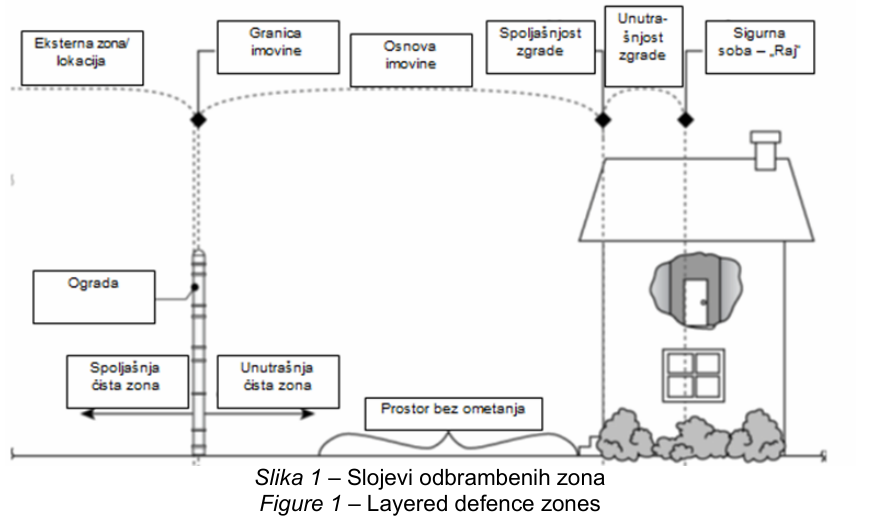
Figure 1 – Layered defence